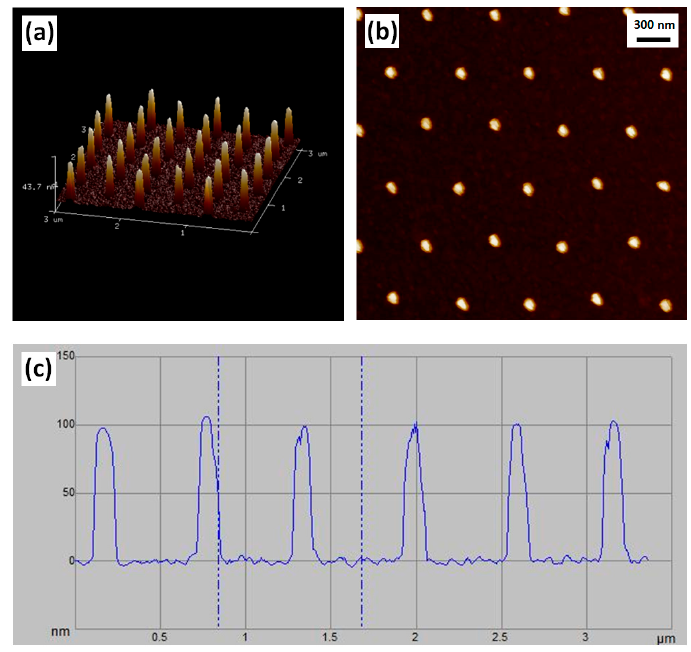
Figure 3. Atomic force microscopy (AFM) images of Si nanopillars related to the exposure dose of 40 µC/cm 2 : ( a ) 3-D image of the Si nanopillars. ( b ) Top-view image of the Si nanopillars. ( c ) Curve of the scanned pillar height.